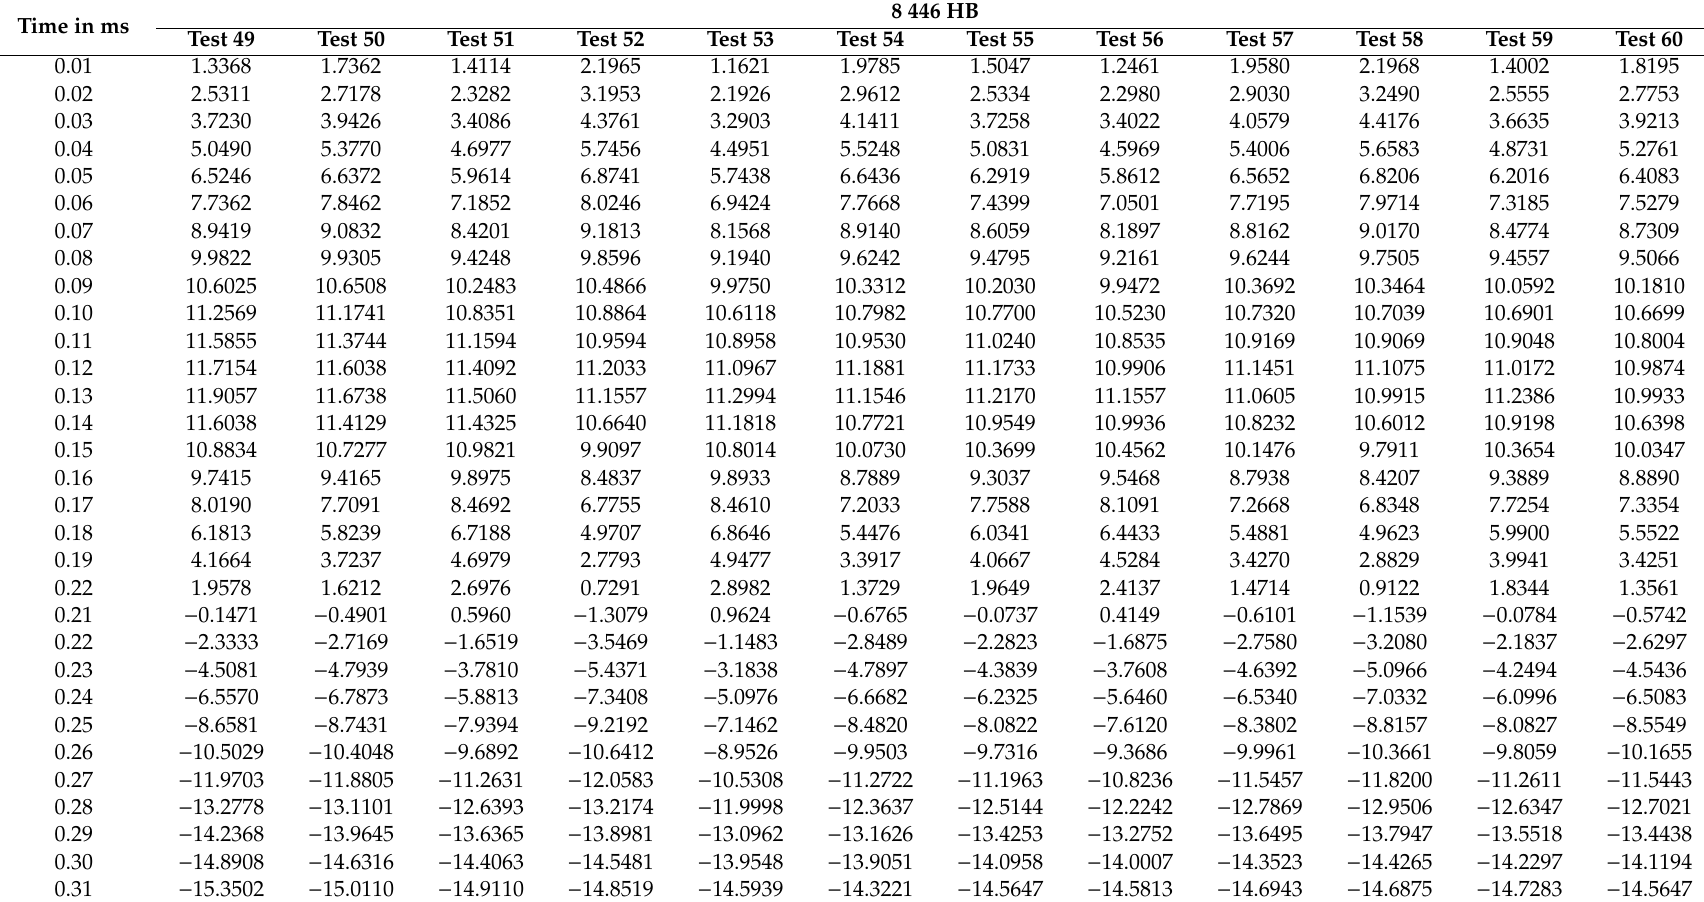
Table A5. Accelerations measured for tests from 49 to